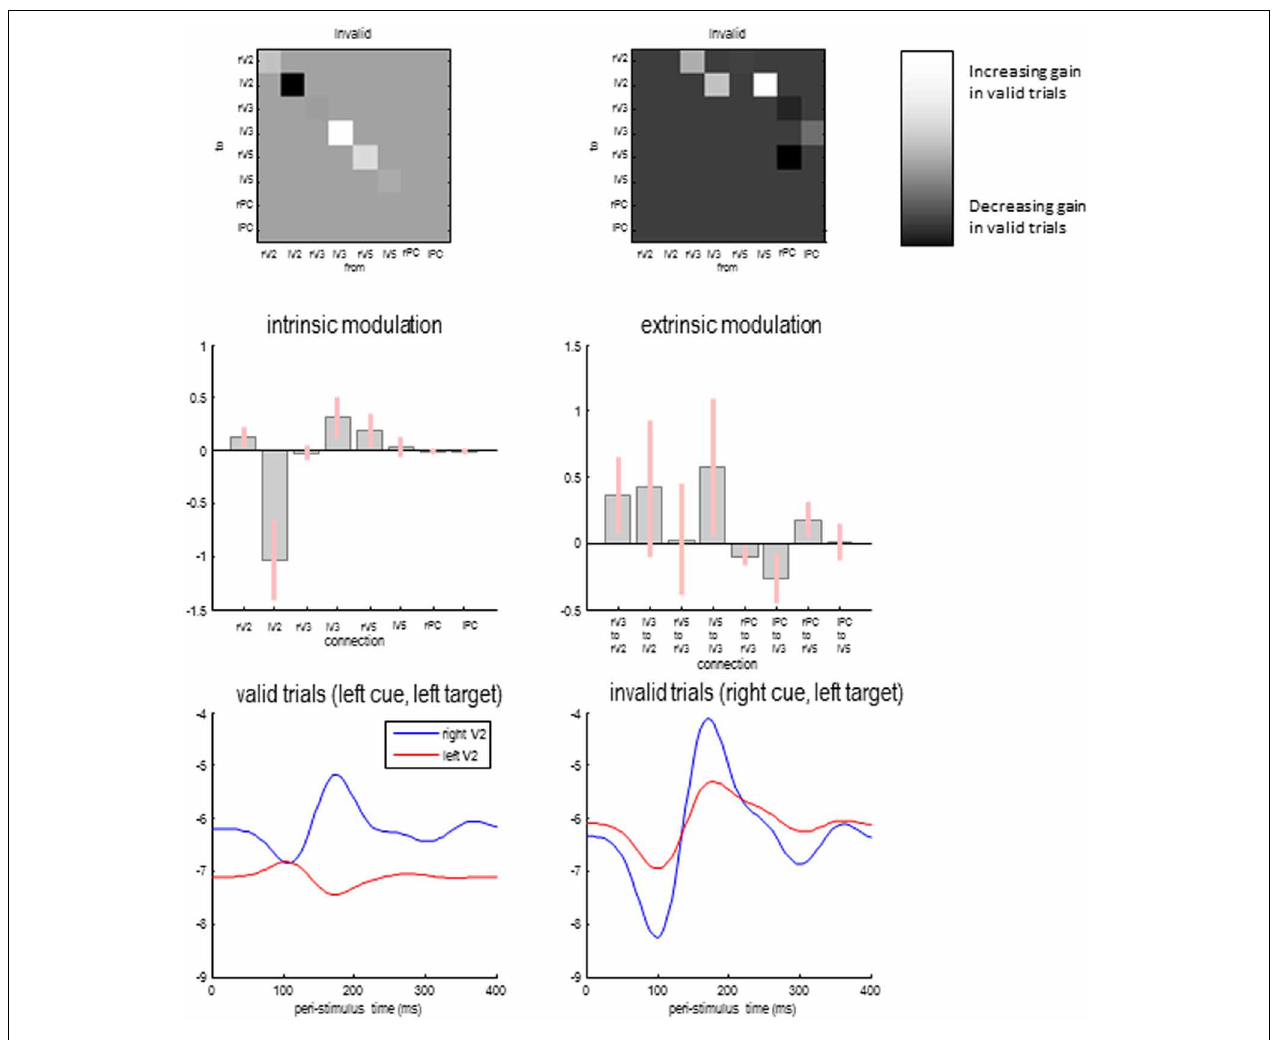
FIGURE 8 | Differences in self-inhibition (upper left panels) and backwards modulation of self-inhibition (upper right panels) between valid and invalid trials for the model with the